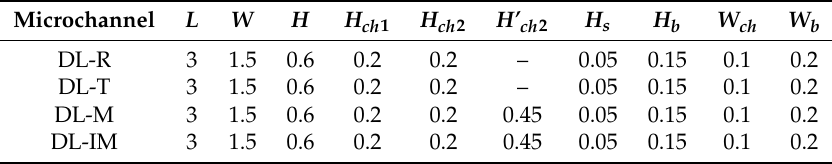
Table 2. Dimension of micro heat